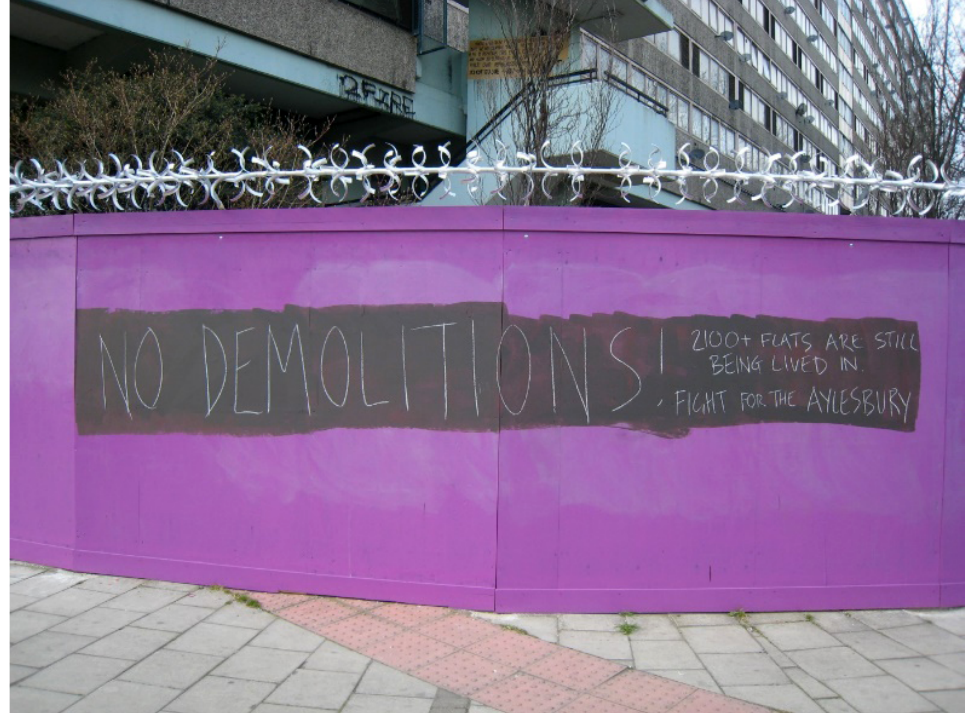
Figure 3. Aylesbury estate: Fortress and ‘no demolitions!’ 2015. Source: Paul